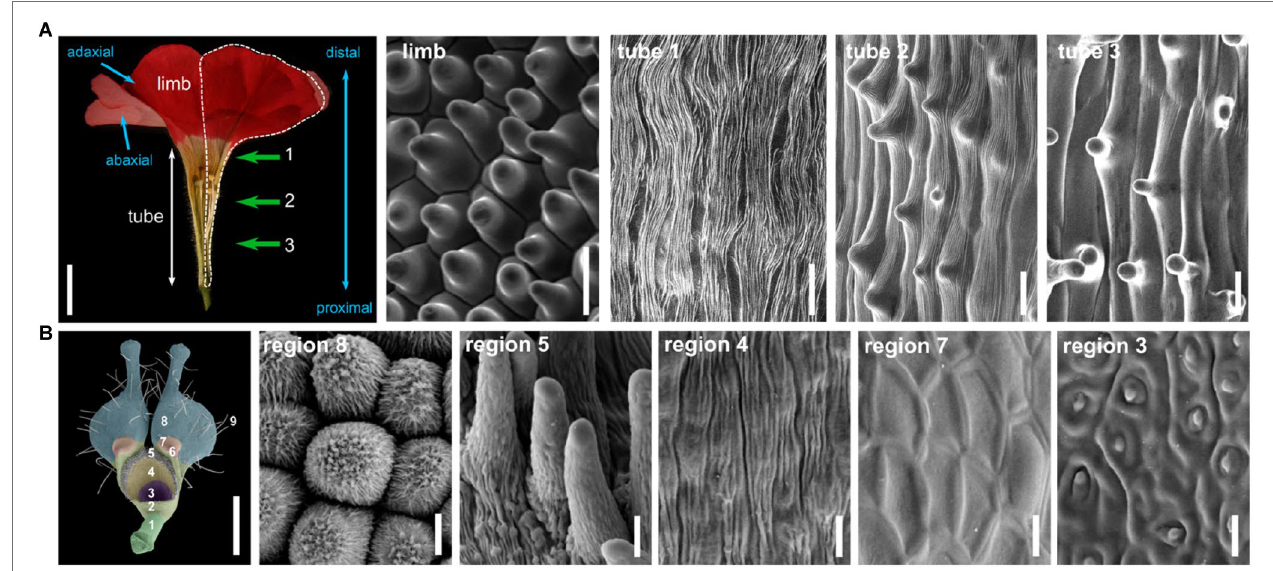
FIGURE 1 | Cellular identities in the petal epidermis. (A) Half-flower from Petunia x hybrida , cut open longitudinally to display the tube and limb regions (scale bar = 1 cm). The contour of one petal is shown with a white dotted line. Proximo/distal and adaxial/abaxial polarities of the petal are indicated with blue arrows. Scanning electron micrographs (scale bars = 20 μ m) of the adaxial surface of petals in the limbs, and at three different regions from the tube, indicated by green arrows and numbers in the flower picture. These pictures were obtained with a HIROX SH-1500 bench top environmental scanning electron microscope equipped with a cooling stage ( − 10 ° C, 5 kV). (B) Petal from Nigella arvensis viewed from its adaxial side (scale bar = 1 mm), with nine regions with different cellular identities as identified in Yao et al. (2019). A 10th region is only visible on the abaxial side of the petal. Scanning electron micrographs of cells from five of these regions, giving an overview of cellular diversity in this organ (scale bars = 10 μ m). Region 8: conical cells; region 5: short trichomes; region 4: oblong cells; region 7: polygonal cells with smooth surfaces; region 3: secretory cells. Pictures are reproduced from Yao et al. (2019) with permission from the